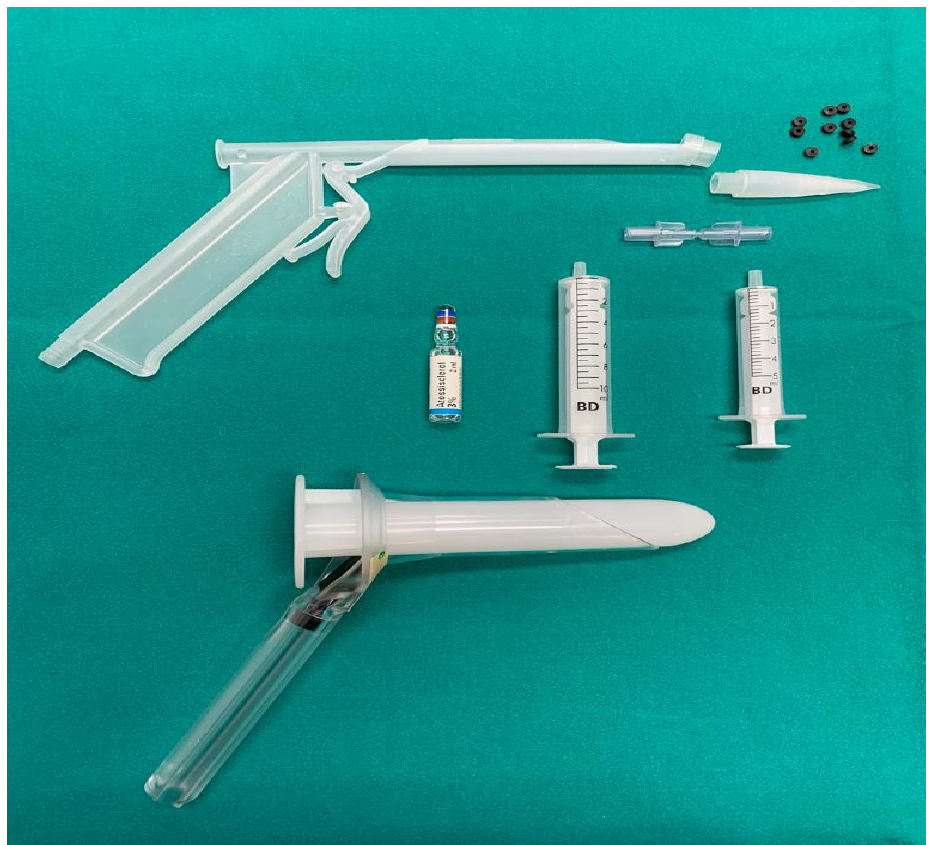
Figure 1. Sclerobanding armamentarium for a single procedure.